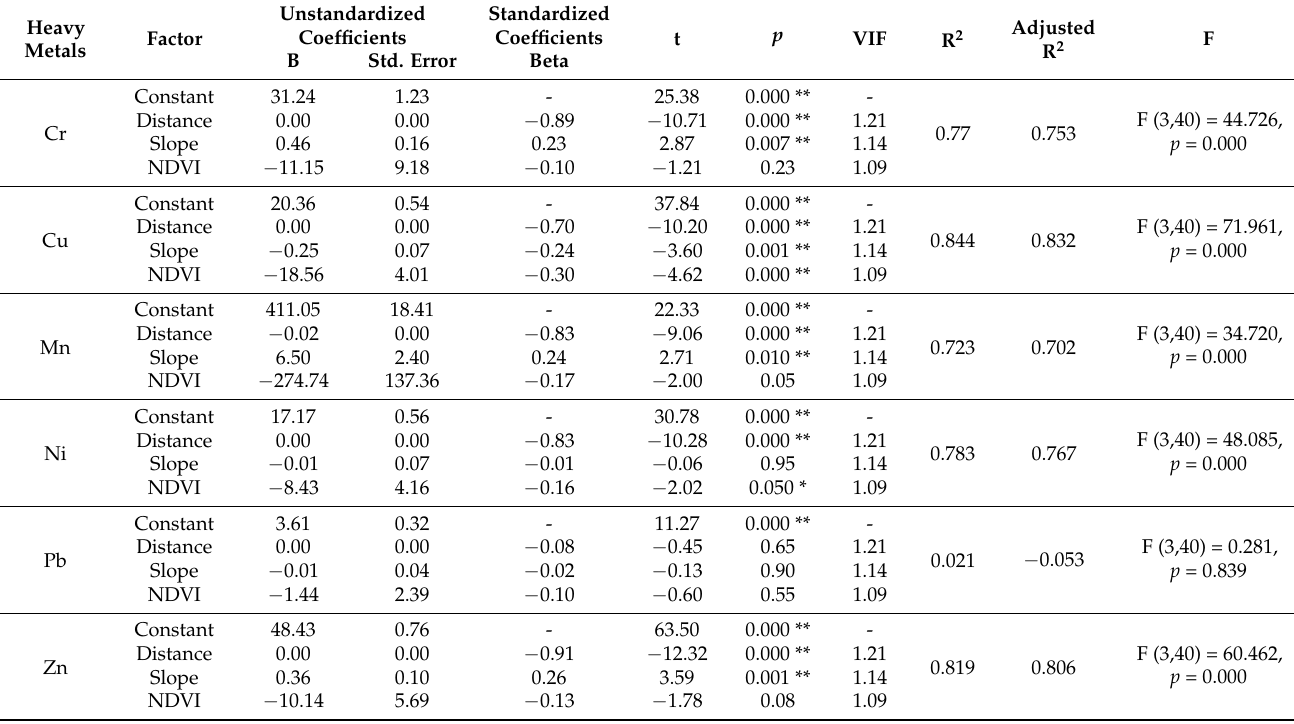
The symbol * indicates the statistical significance at the 0.05 level, and the symbol ** indicates the statistical significance at the 0.01